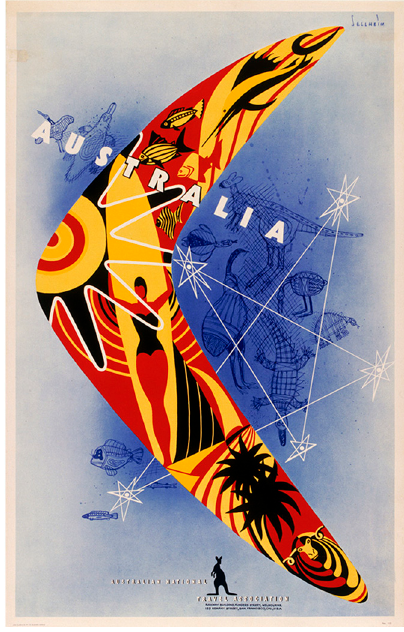
Figure 1. Advertising poster, ‘Australia’, colour, lithograph, paper, designed by Gert Sellheim for the Australian National Travel Association, printed by Litho, McLaren & Co., 1956–1957. Image courtesy Museum of Applied Arts and Sciences, Sydney © Joseph Lebovic.